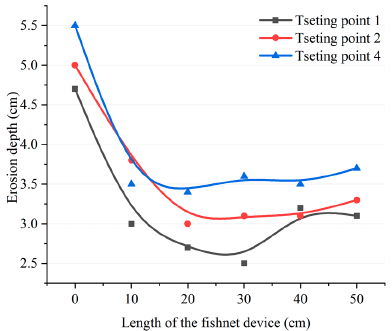
Figure 22. Erosion depth when the fishnet device had different lengths.